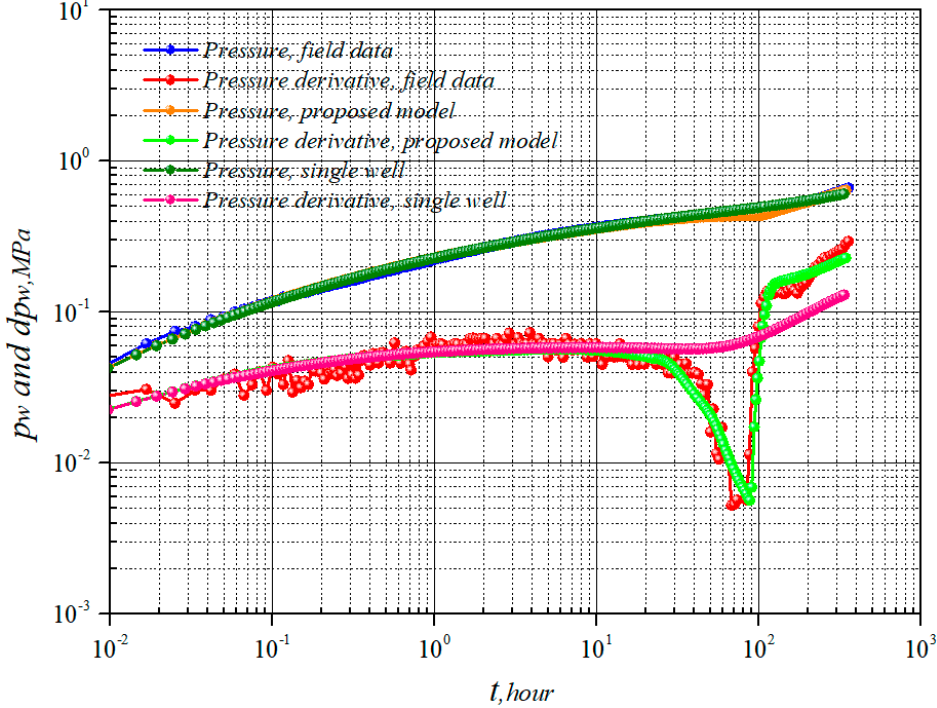
Figure 12. Pressure and pressure derivative match results in the fourth cycle of cumulative gas injection for case 2. Table 6. The reservoir, well, and gas properties in pressure transient analysis of case 2. Table 5. The reservoir, well, and gas properties in pressure transient analysis of case